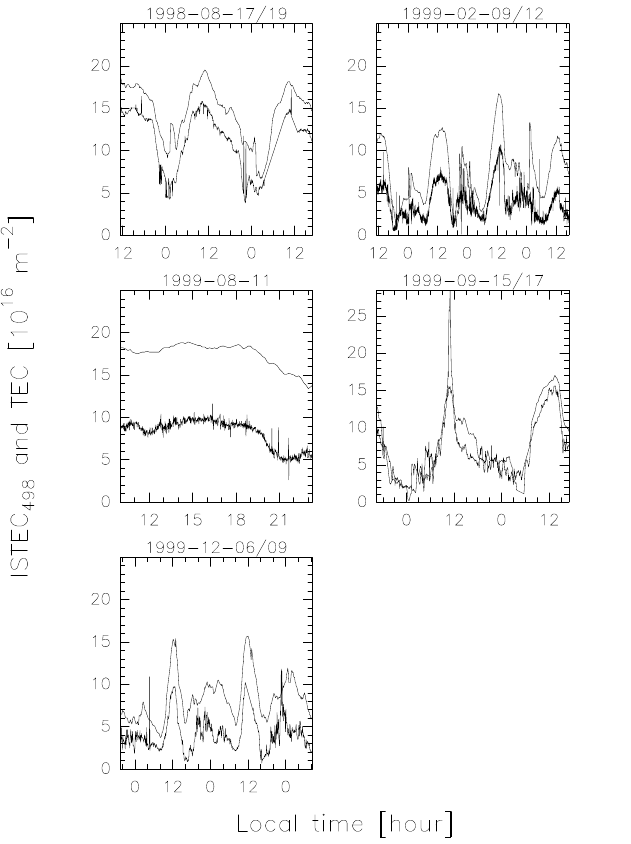
Fig. 1. Comparison between GPS TEC (thin lines) and the ISTEC 498 derived from the uncalibrated EISCAT measurements (bold lines).